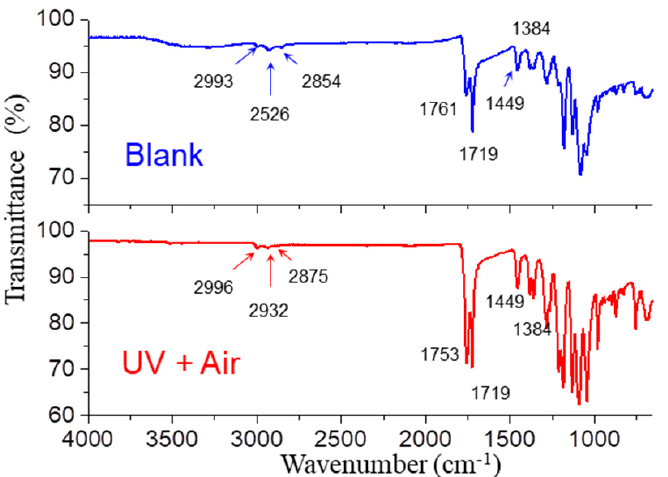
Figure 7. FTIR-ATR spectra of PLA/PHB textiles before and after 14 days immersion in natural seawater under both UV light radiation and air gas bubbling condition.